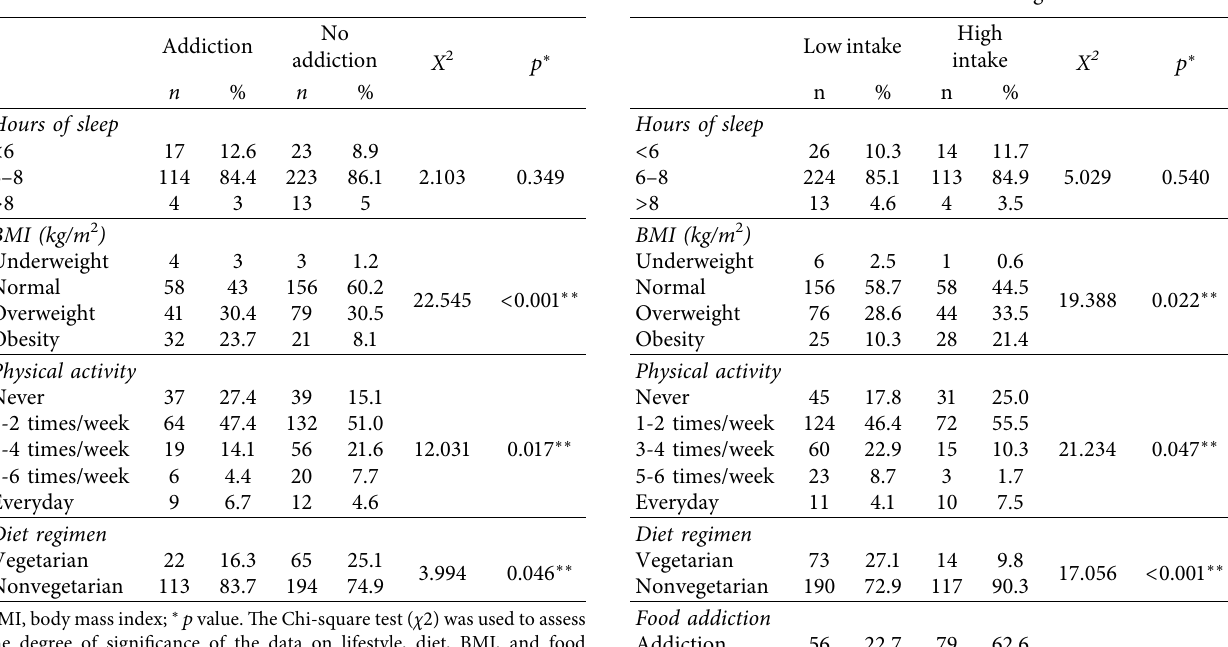
Table 3: Hours of sleep, BMI, physical activity, diet, and food addiction based on saturated fat intake categories.